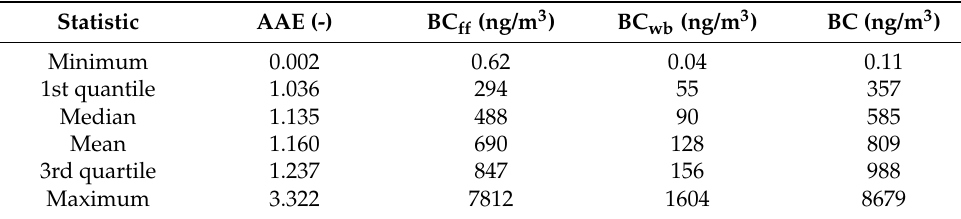
Figure 4. Time variability plot for BC ff and BC wb contributions. Table 1. Statistical summary of campaign results 1 Table 2. Comparison of ambient BC measurements in east Santiago, monthly averages (ng/m 3 ).